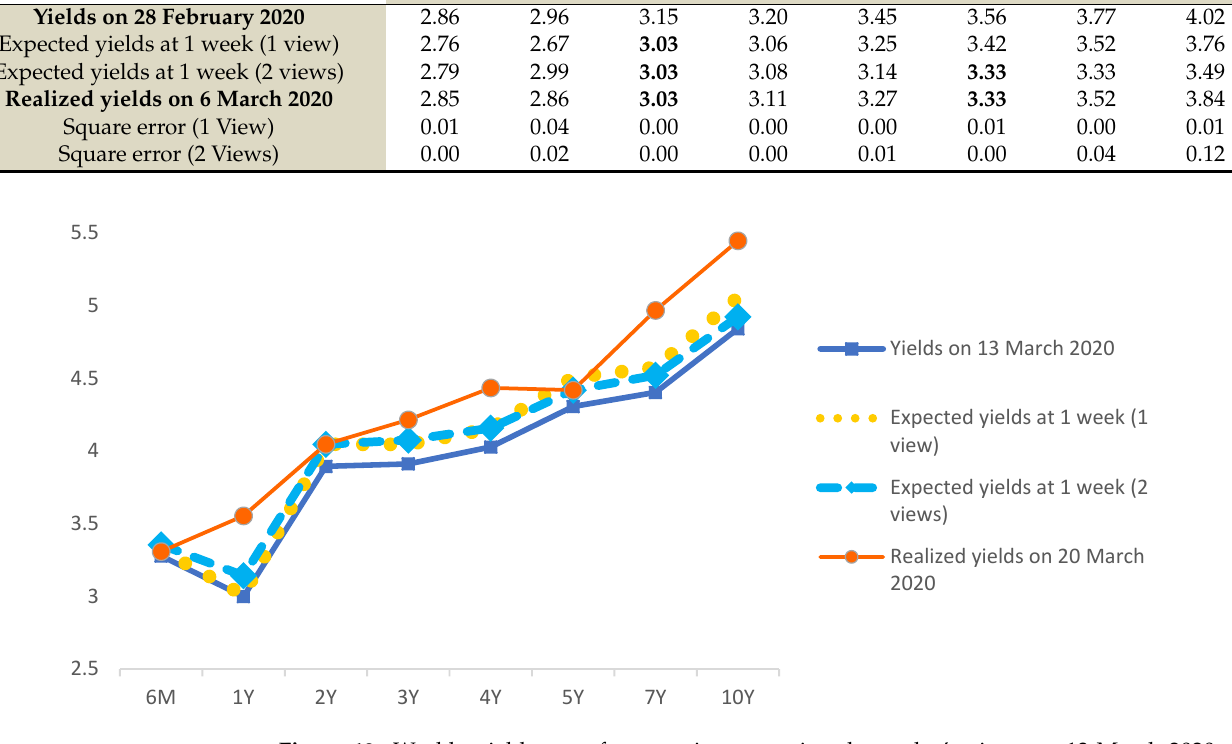
Figure 19. Weekly yield curve forecasts incorporating the trader’s views on 13 March 2020 and realized yields on 20 March 2020. Source: Bloomberg, own computation.